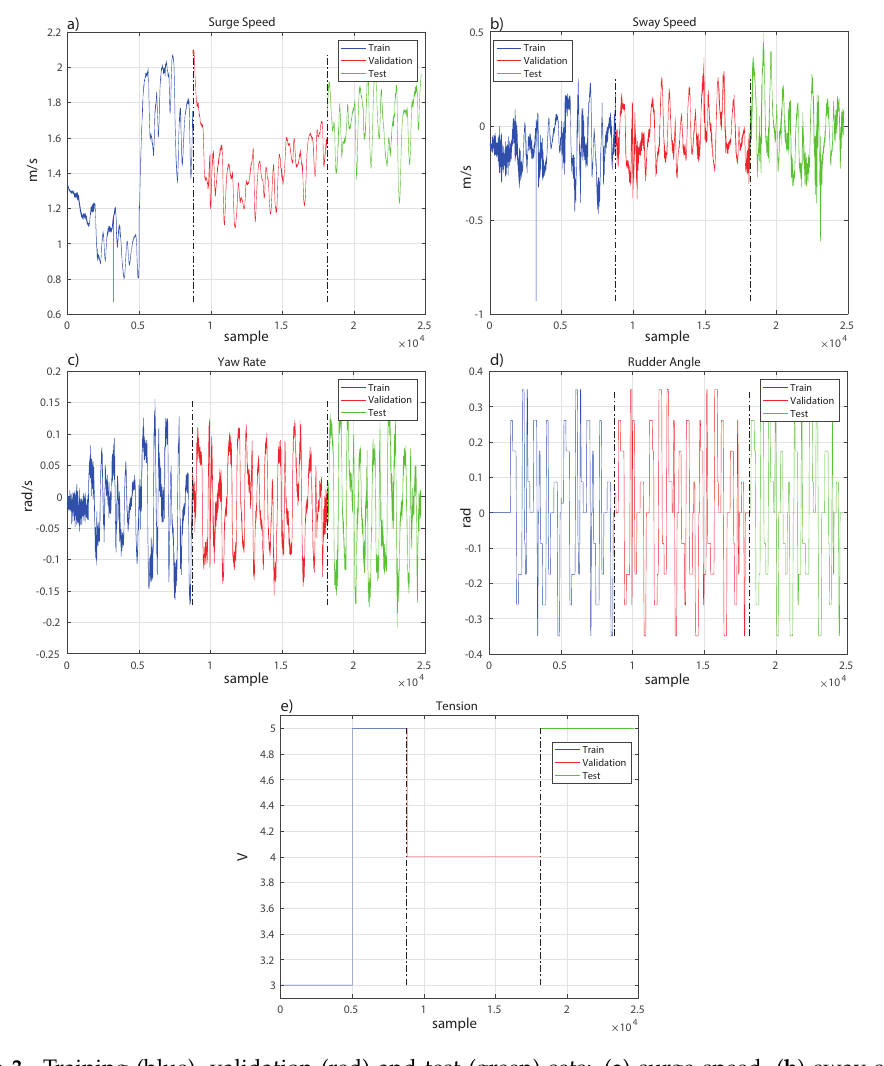
Figure 3. Training (blue), validation (red) and test (green) sets: ( a ) surge speed, ( b ) sway speed, ( c ) yaw rate, ( d ) rudder angle, and ( e ) tension of the